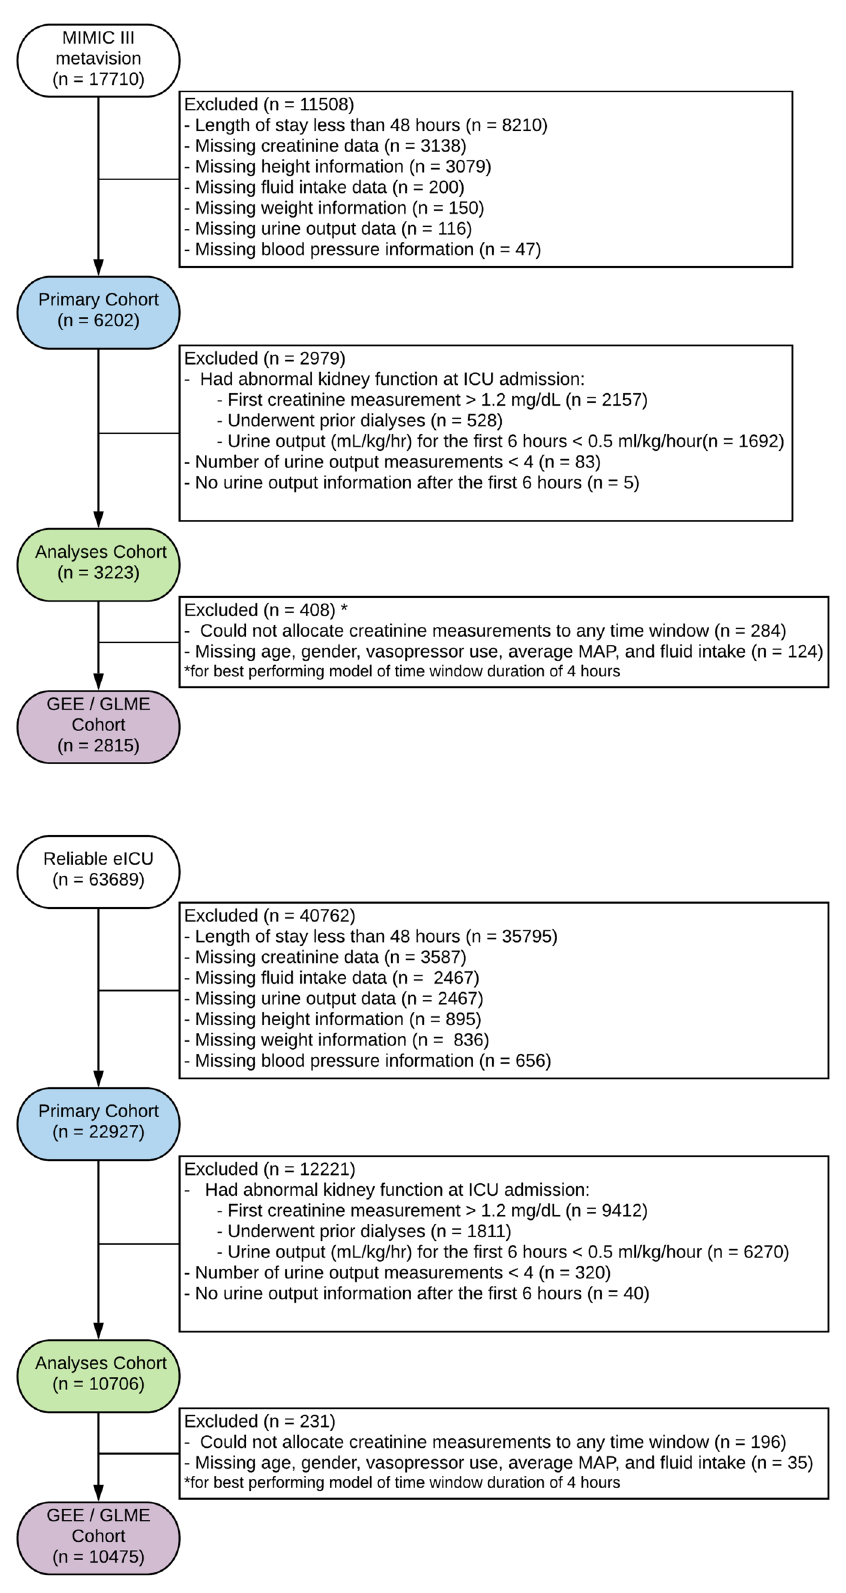
Figure 1. Study schematic of MIMIC-III and eICU cohorts. Study flow-diagram showing initial (primary), non-parametric analysis (analyses), and parametric model GEE (GEE) cohorts of MIMIC-III (top) and eICU (bottom). The initial number of patients in the databases are shown, and detailed exclusion criteria are presented. The numbers of patients who met each criterion does not sum to the total number excluded, as one patient may meet more than one exclusion criterion. UO urine output, GEE generalized estimating